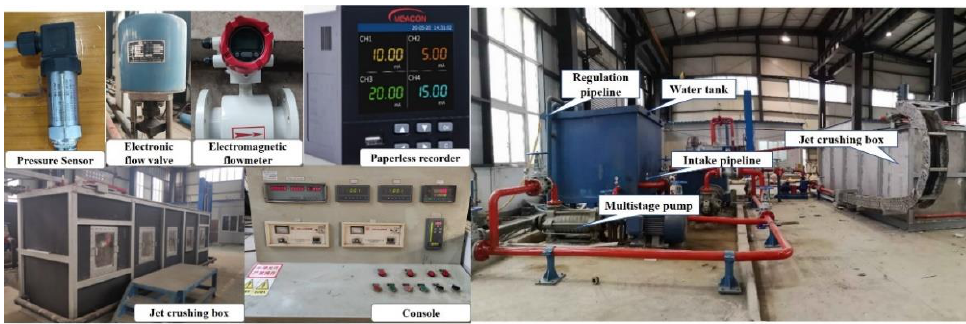
Figure 11. Experimental prototype of PJCT. ( a ) Parts of PJCT; ( b ) Overall Structure of PJCT Test Prototype.